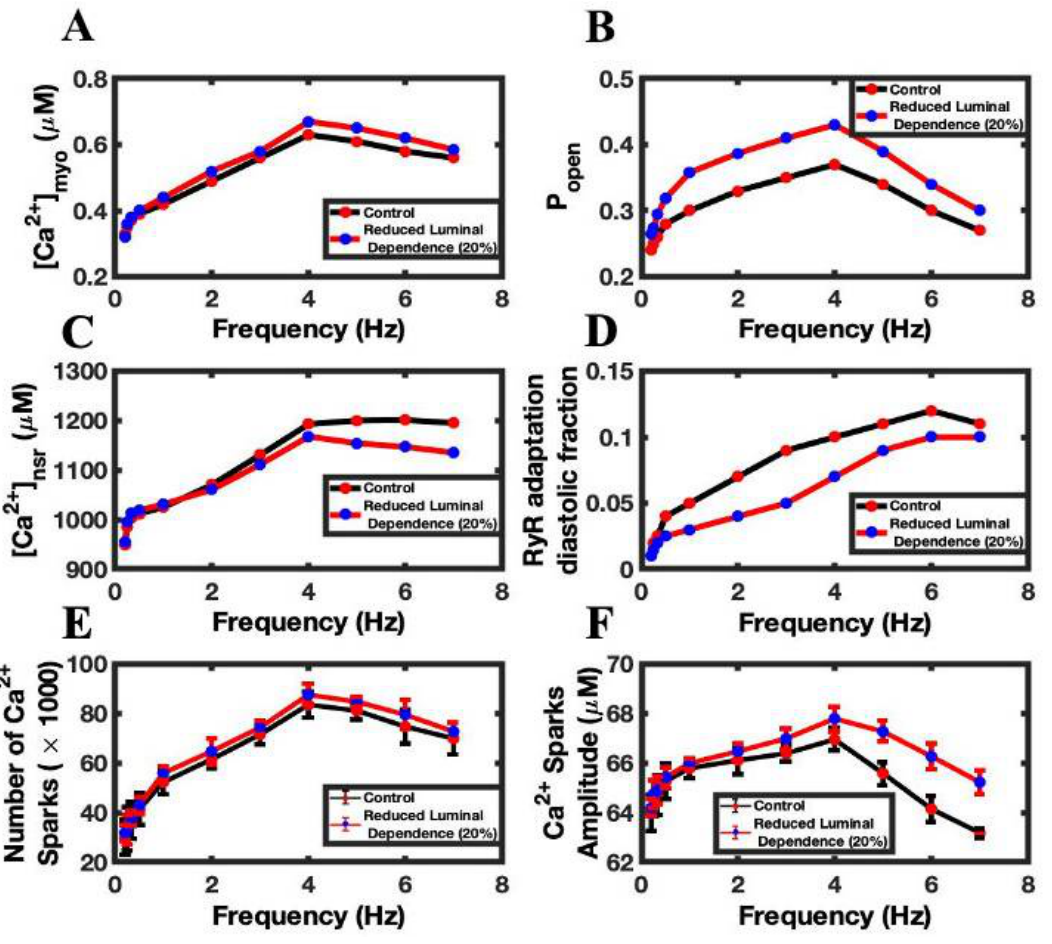
Figure 8. The effects of reduced RyR2 adaptation on frequency-dependent phenomena. ( A ) Peak myoplasmic Ca 2+ concentration. ( B ) RyR2 open probability. ( C ) Peak NSR Ca 2+ concentration. ( D ) Diastolic fraction of RyR2 in the adapted state. ( E ) Number of Ca 2+ sparks. ( F ) Ca 2+ spark amplitude. Control simulations are shown in black. Simulations with reduced RyR2 adaptation are shown in red.